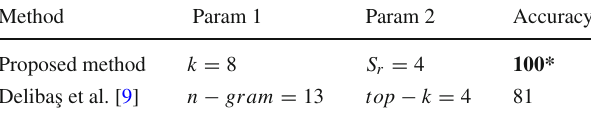
Here, Column 1 represents the methods, Columns 2 and 3 list most important two parameters, and last column represents the performance